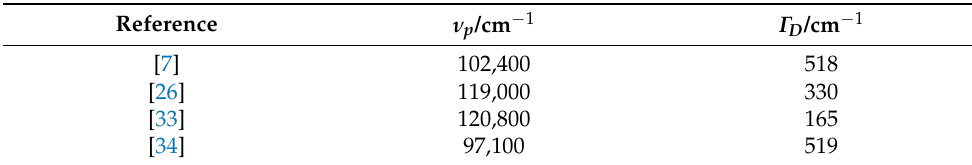
Table 1. Survey of literature data on aluminum Drude parameters. Numerical values have been adopted to the writing of the Drude function given in Equation